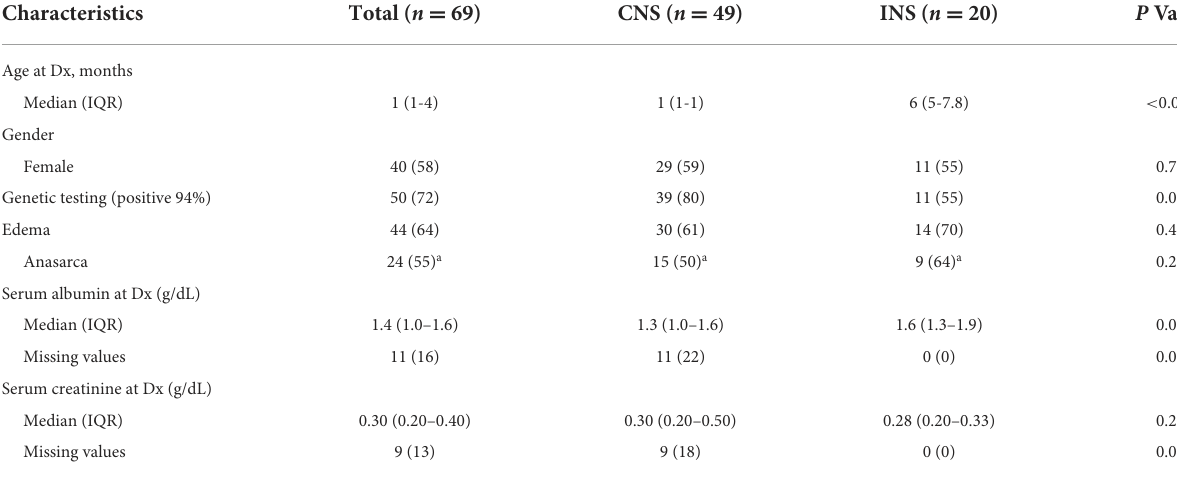
TABLE 1 Baseline characteristics in children with CNS and INS.